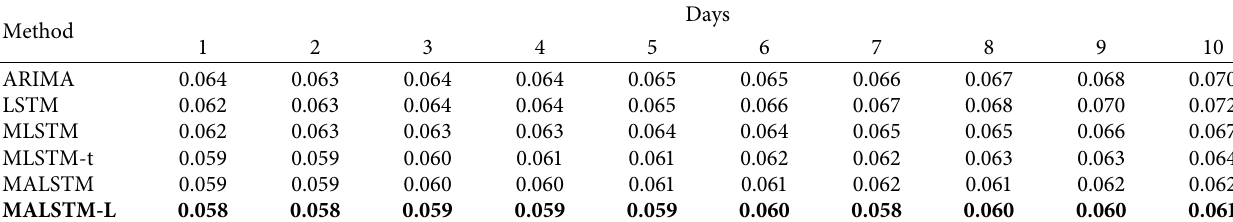
Table 1: The RMSE results of the market amount prediction in the next 10 days.